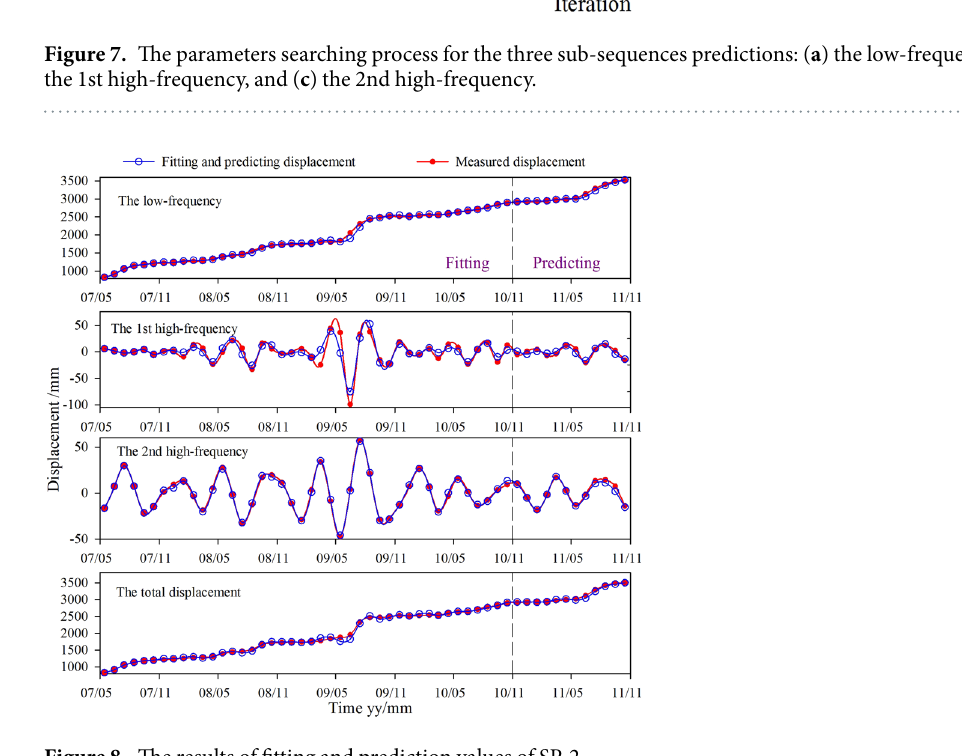
Figure 8. The results of fitting and prediction values of